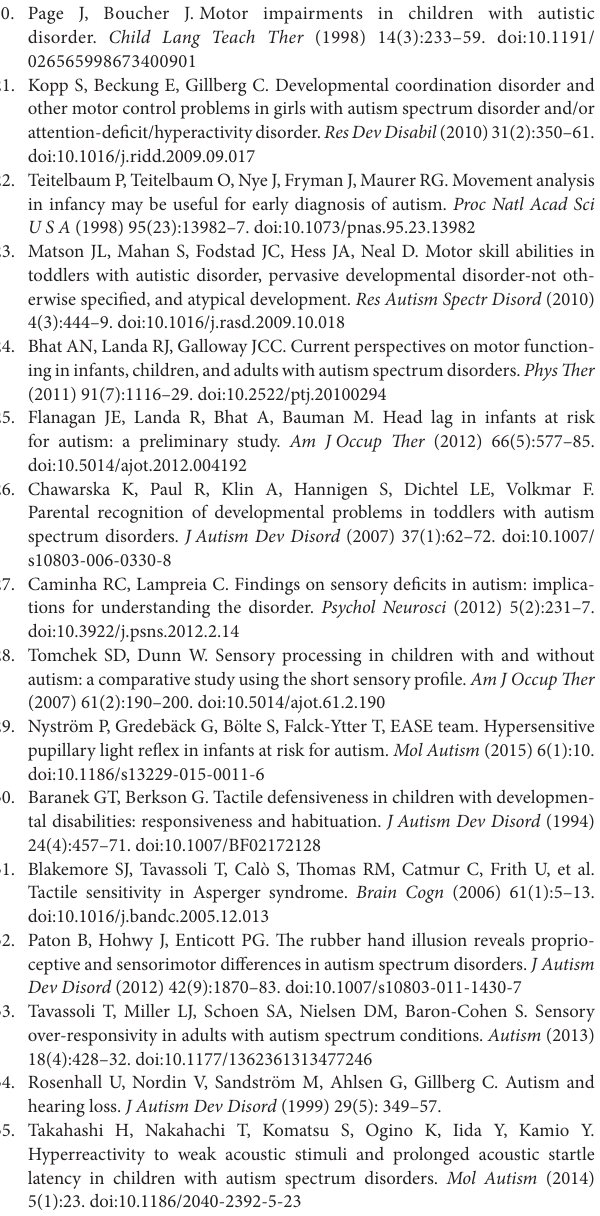
table s1 | summary of all studies included in the role of sensorimotor difficulties in the development of autistic spectrum conditions . Summary of demographics, methods and outcomes of all studies included in